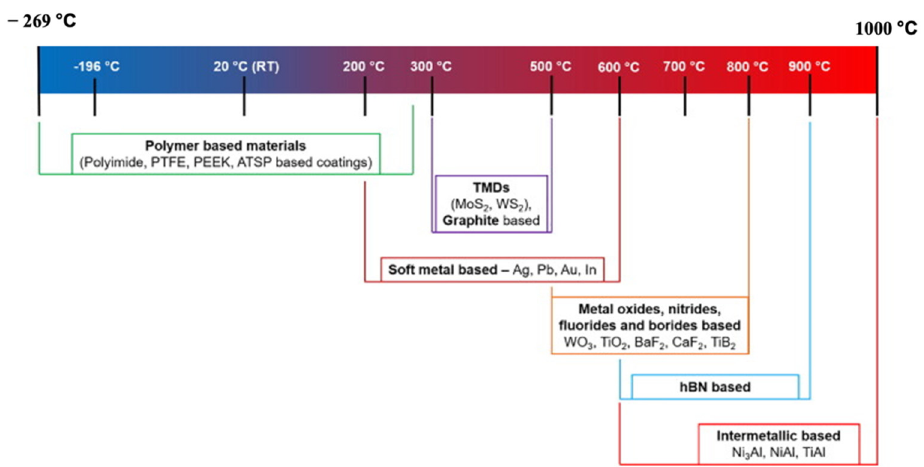
Figure 3. Stable working temperature for different solid lubricants. Reproduced with permission from [57] . Copyright Elsevier, 2021.